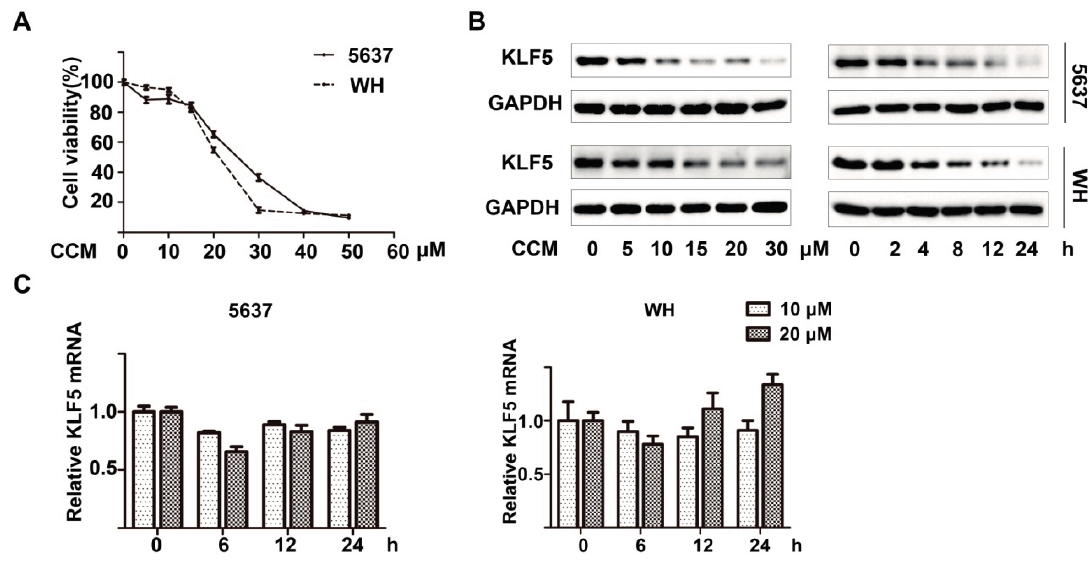
Figure 1. Curcumin down-regulated KLF5 protein expression in a dose- and time-dependent manner. ( A ) 5637 and WH bladder cancer cells were treated with the indicated concentration of curcumin (CCM) for 48 h; then the cell viability was determined by the 3-(4,5-dimethylthiazol-2-yl)-2,5-diphenyltetrazolium bromide (MTT) assay; ( B ) After being treated with various concentrations of curcumin for 12 h or with 15 μ M of curcumin for the indicated period, KLF5 protein expression was determined by western blot analysis; and ( C ) KLF5 mRNA expression levels were analyzed by real-time qPCR after 5637 and WH cells were treated with 10 or 20 μ M curcumin for 6, 12 and 24 h. Results were presented as mean ± SD from three independent